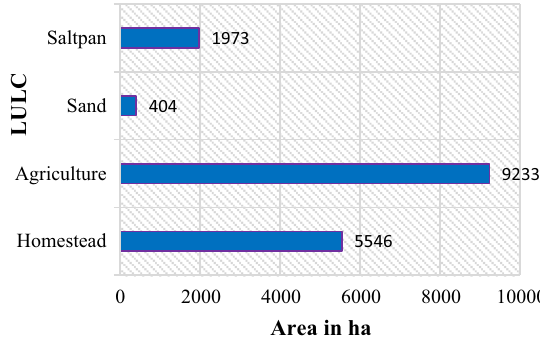
Fig. 16 Transformation of mangrove forest into other LULC classes